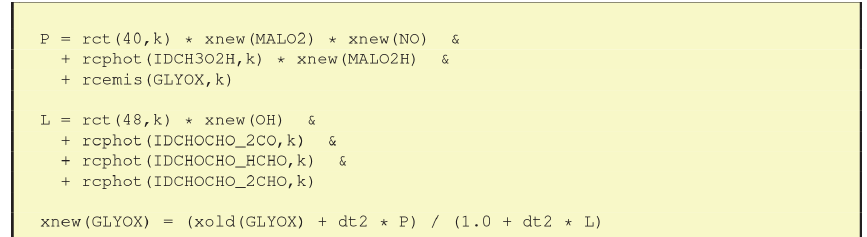
Figure 1. Example equations from the output file, CM_Reactions1.inc , for the model species GLYOX (glyoxal). “ P ” gives the production terms, and “ L ” gives the loss terms, with the last line giving the TWOSTEP solution for this species. See Sect.